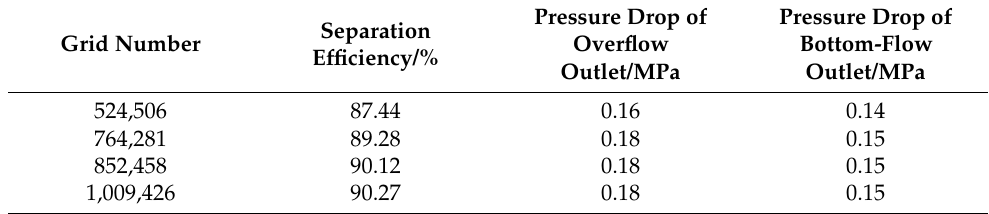
Table 1. Test and verification of grid